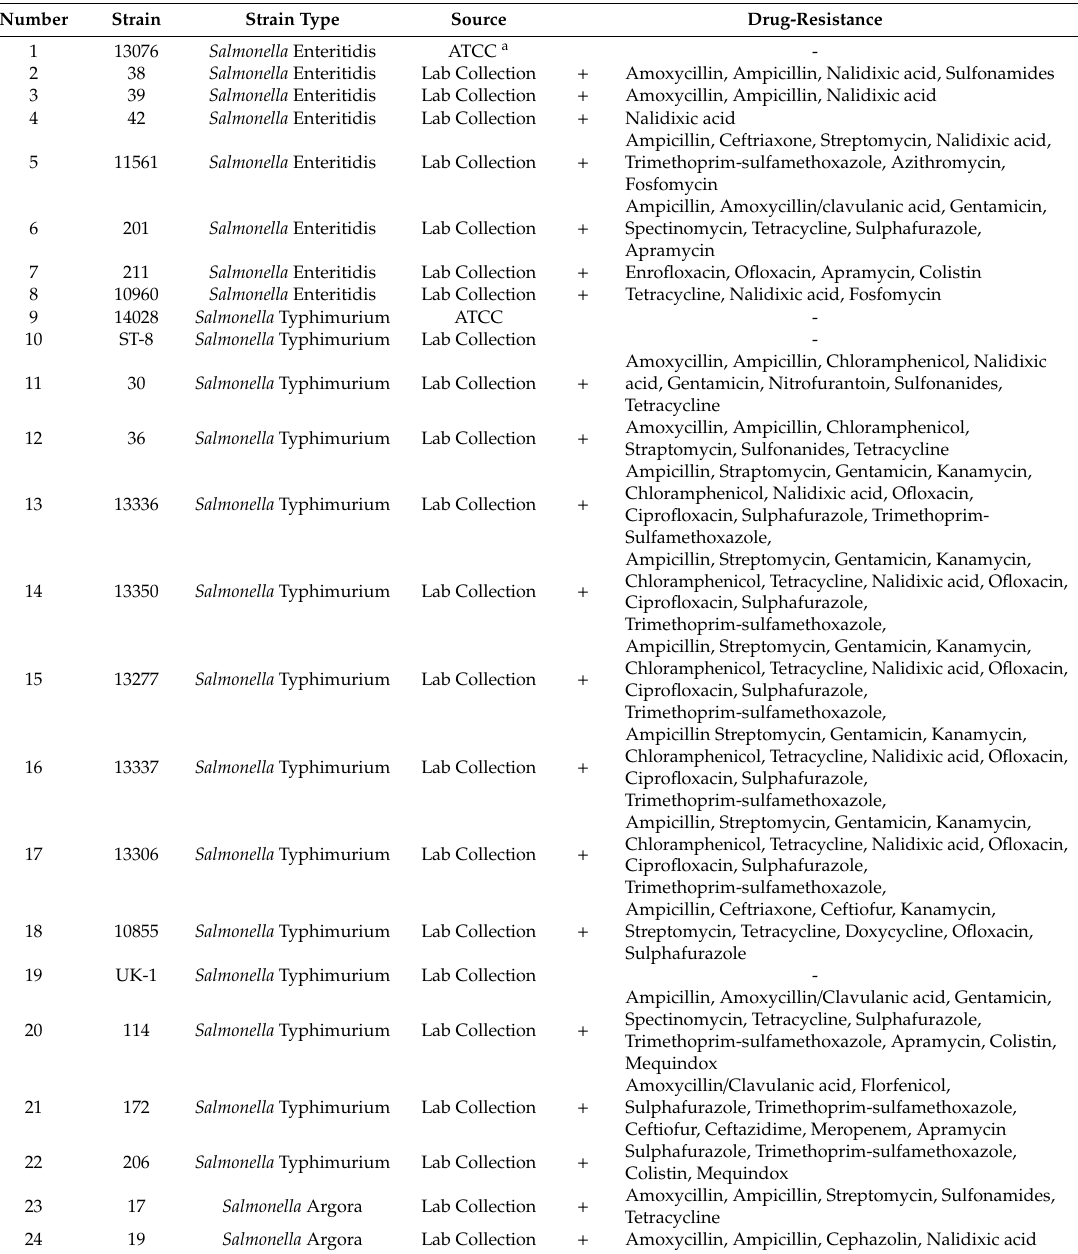
Table 1. Bacterial strains used in the